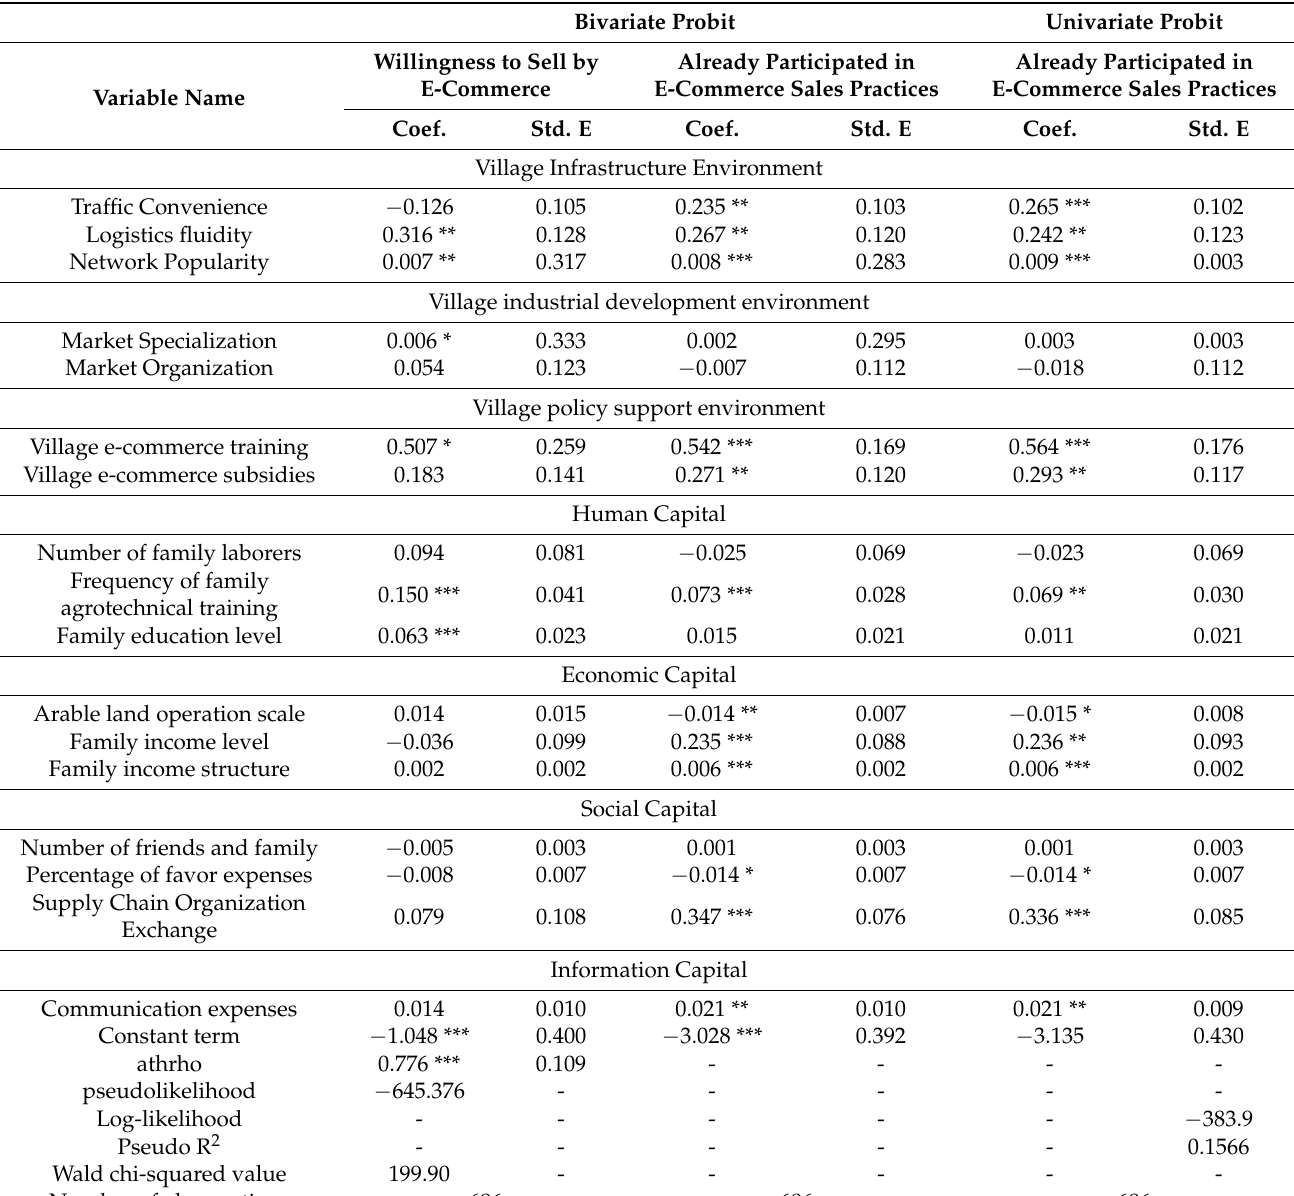
Table 3. The results of the impact of village environment and capital endowment on Farmers’ e-commerce sales demand and